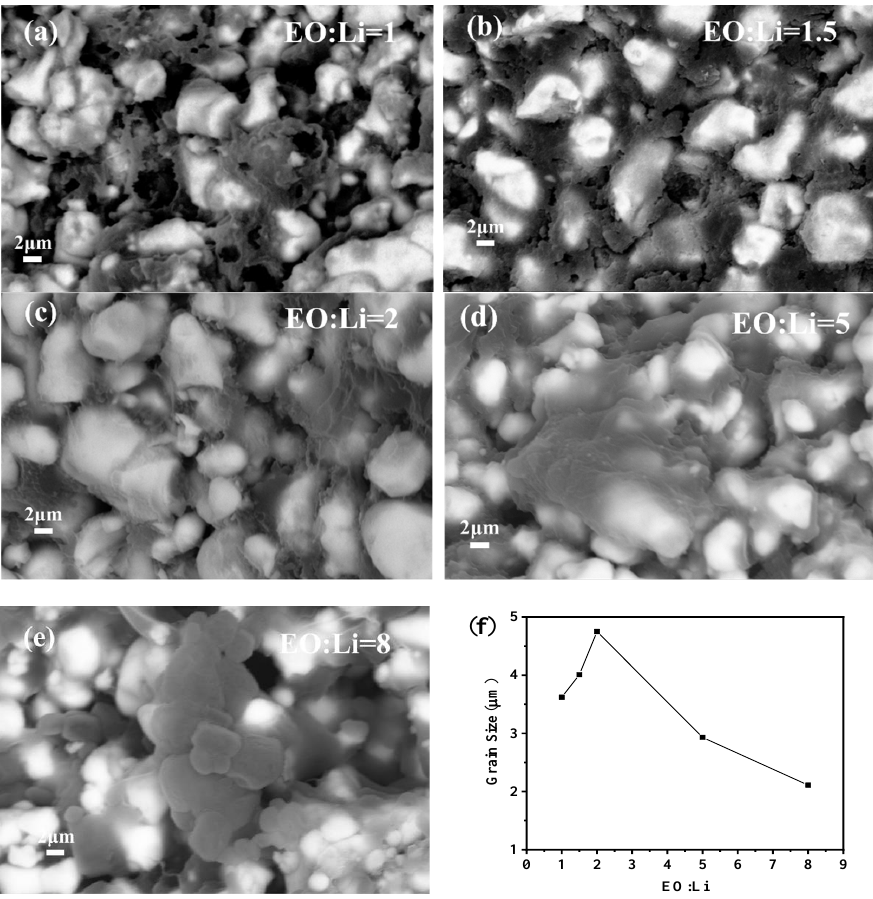
Figure 4. ( a – e ) BSE images and ( f ) grain size of cold-sintered LLZTO-PEO x -LiTFSI composite electrolytes with different EO to Li molar ratios.